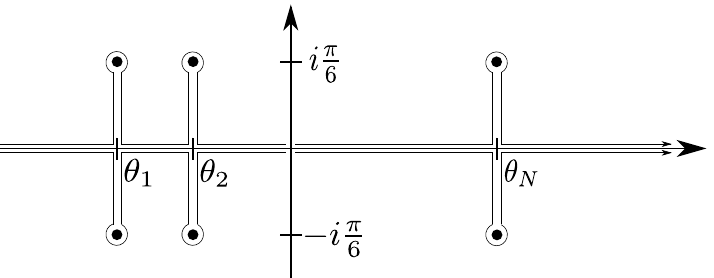
Figure 1 . Integration contour, which contains both the F - and the (cid:22) -terms. The integrand is half the F -term integrand both on the upper and on the lower